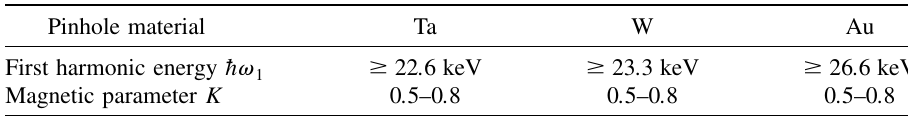
TABLE III. Parameters of a clean undulator for x-ray alignment.